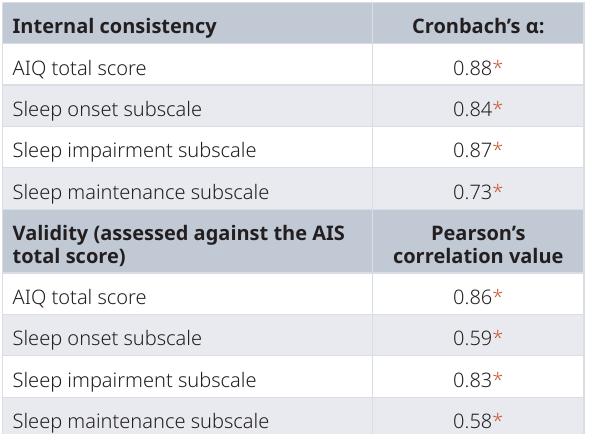
Table 4. Internal consistency and validity.